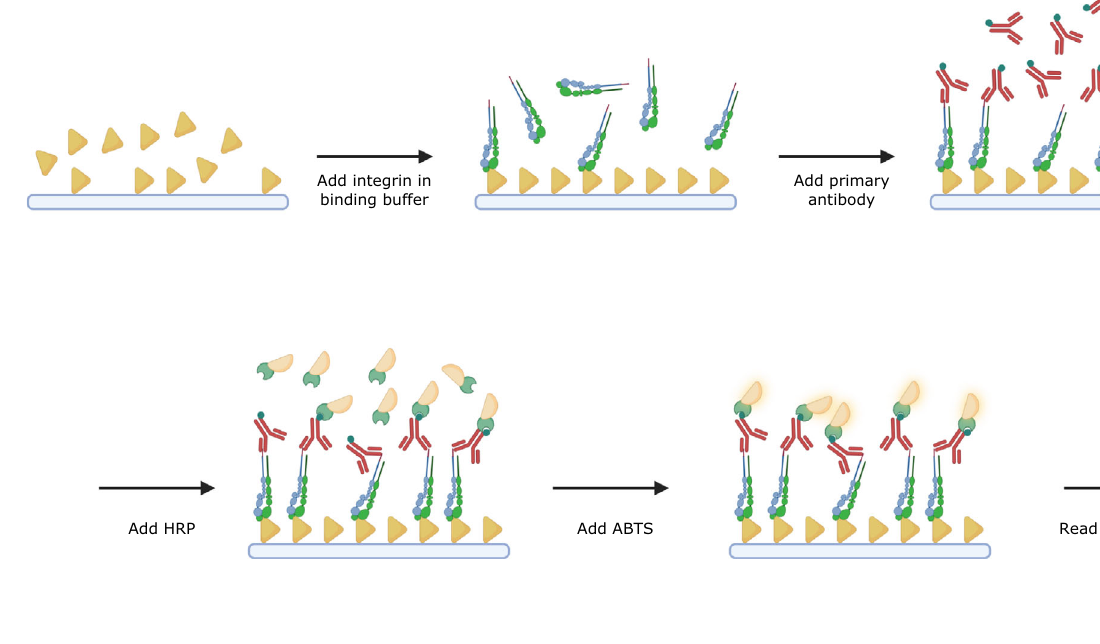
Tomograms were manually segmented using AMIRA (Thermo Fisher Scienti fi c) or 3DMOD (IMOD). The data was plotted using GraphPad PRISM.